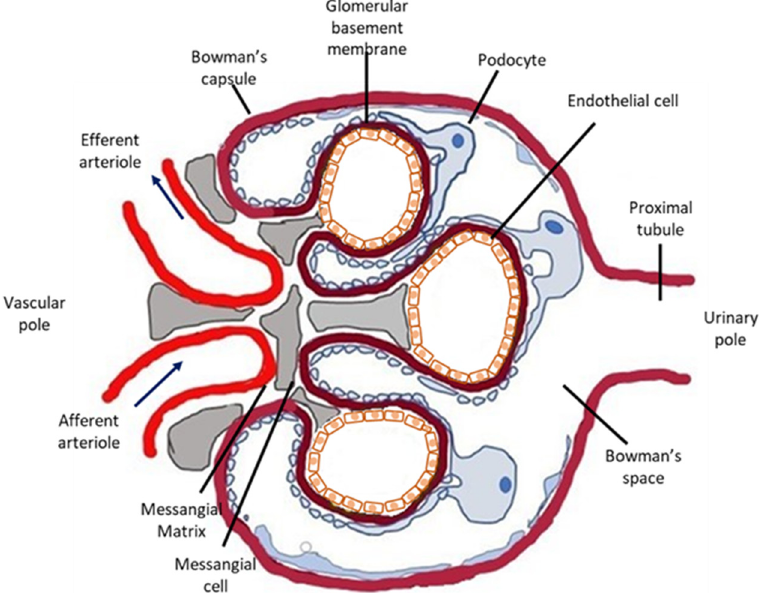
Figure 1. Schematic representation of the glomerulus. The glomerulus is a cluster of capillaries within the Bowman’s capsule. Three different cell types comprise the glomerulus: endothelial cells, epithelial cells (podocytes) and mesangial cells. Endothelial cells are fenestrated, while mesangial cells and the mesangial matrix support the glomerular capillaries. Podocytes are located on the urinary side of the glomerular basement membrane, and they have long foot processes that wrap around the glomerular capillaries.